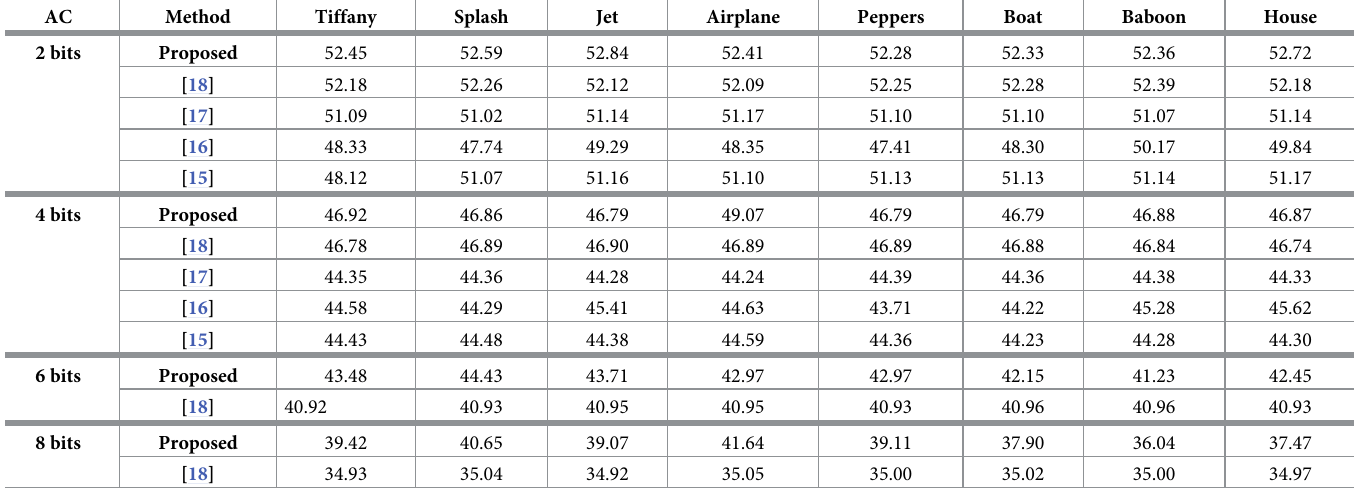
Table 2. PSNR comparisons for various lengths of